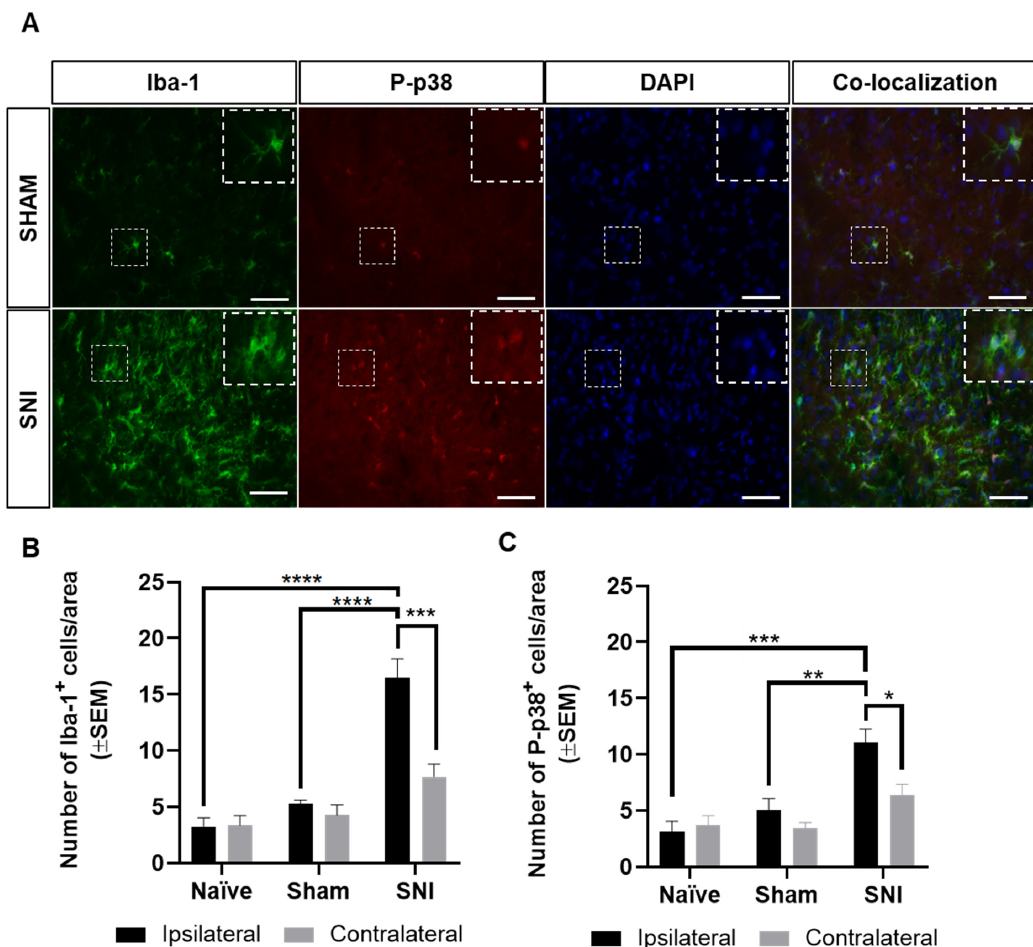
Figure 7. Immunohistochemical characterization of microglial reaction in the SNI model. ( A ) Representative confocal microscopy images of microglia characterization (Iba-1 and P-p38) in the lumbar spinal cord of sham and SNI-operated rats. Co-localization of Iba-1 and P-p38 was estimated as 97.7% (n = 3). Note that the microglia depictured in the insert of SNI-operated rats demonstrate two P-p38 + and Iba-1 + microglia and a microglia only positive for Iba-1. Images were obtained with a 40 × objective lense, and scale bars indicate 50 µ m. ( B ) The ipsilateral dorsal horn of SNI-operated rats presented a significantly higher number of Iba-1 + cells compared with contralateral side, and with the ipsilateral dorsal horn of naïve and sham rats. ( C ) The ipsilateral dorsal horn of the lumbar spinal cord of SNI-operated rats presented a significant upregulation in the number of P-p38 + cells compared with the contralateral side and with the ipsilateral dorsal horn of naïve and sham rats. ( B , C ) Naïve n = 3, sham n = 4, SNI n = 5. Data are presented as mean ± SEM. * p < 0.05; ** p < 0.01; *** p < 0.001; **** p < 0.0001. 2.6. Pharmacological Inhibition of Spinal Microglia Does not Ameliorate Nociception in the CIBP Rat Model To further confirm that microglial reaction is not a main feature of the Walker 256 model of CIBP, we investigated whether pharmacological inhibition of spinal microglia had an anti-nociceptive effect. Female Sprague Dawley rats inoculated with Walker 256 cancer cells developed pain-related behaviors over time, seen as a pronounced decrease in limb-use scores from post-surgical day 8 (Figure 8A). Upon reaching a limb-use score of 1, rats were randomized to receive a single intrathecal dose of the microglial inhibitor minocycline (100 µg), morphine (10 µg), or vehicle. Intrathecal administration of 100 µg minocycline had no effect on the observed pain-related behavior as